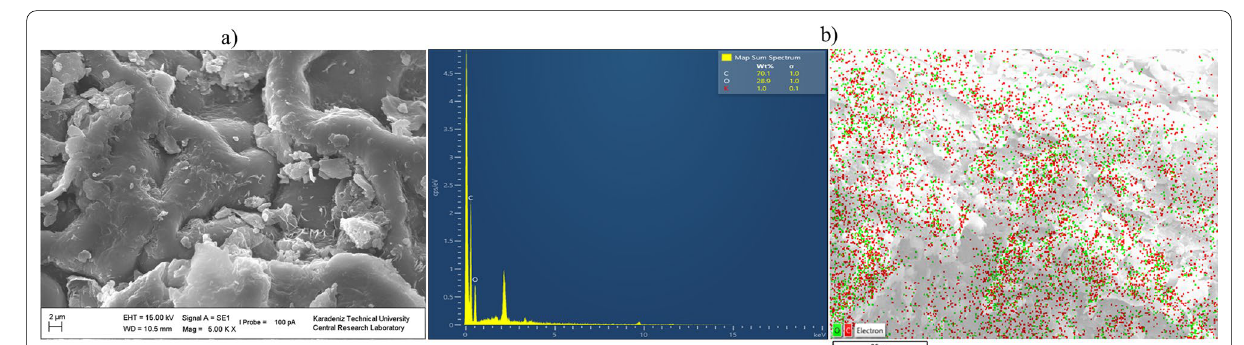
Fig. 3 a SEM micrographs BTW b EDX images of